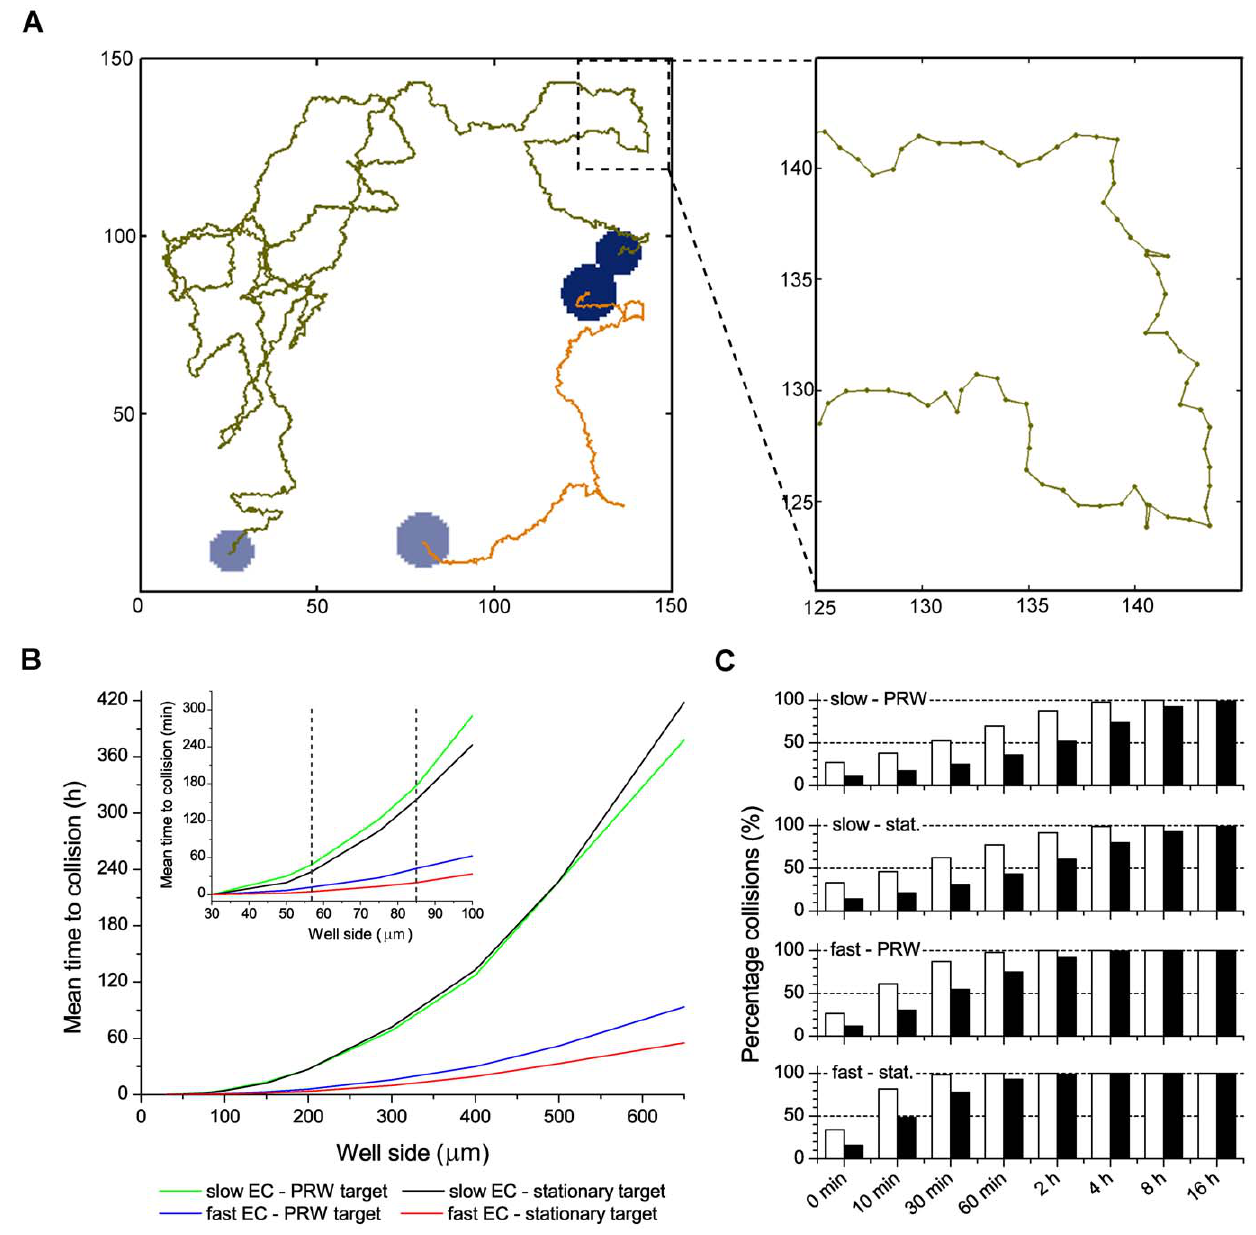
Figure 5. Simulation of time to cell-cell encounter in differently sized wells. One target cell and one effector cell (EC) were randomly placed together in a square well and the mean time to collision was simulated running 1024 times for each well size. The EC was either migrating slow (mean speed=2 m m/min) or fast (mean speed=15 m m/min) while the target cell were considered to be either motile (mean speed=2 m m/min) or stationary. (A) Example of simulated trajectories shown from the time of seeding (light blue circles) to collision (dark blue circles) for a fast EC (Ø 13 m m) with a motile target cell (Ø 16 m m) in a 150 m m well, part of the track is enlarged to show the individual steps. (B) Graph of mean time to collision for the slow EC with migrating (green) or stationary (black) target cell and the fast EC with migrating (blue) or stationary (red) target cell as a function of well side length. Inset shows an enlargement of the graph for smaller well sizes. The two dotted vertical lines correspond to the two well sizes used in the experiments; 57 m m (silicon) and 85 m m (PDMS). (C) Distribution histograms showing the percentage of collisions after a certain time simulated for the two well sizes used in the experiments; white bars:57 m m and black bars:85 m m.